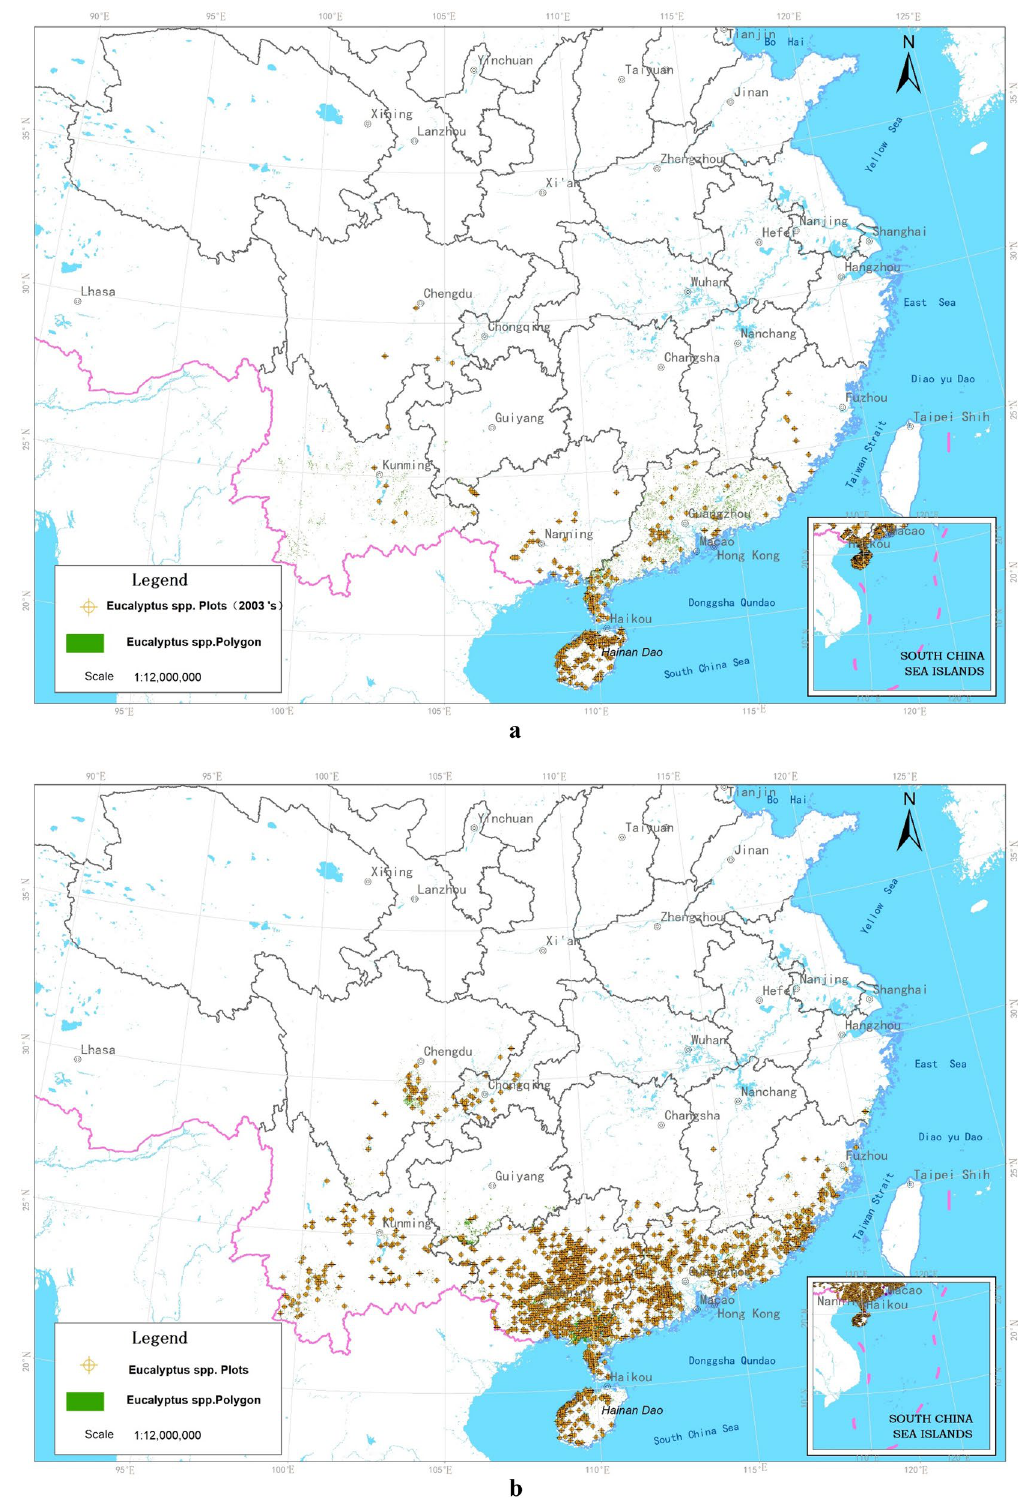
Figure 1. Distribution of eucalyptus in the south of China [( a ) 2003; ( b ) 2016]. This figure was created by spatially overlaying spatial sample plots data from National Forest Inventory (NFI) and patch vectors data from China Forest-Land Database Map (CFLDM), ( a ) shows that the point data are from 6th NFIs eucalyptus sample plots and the polygon vector data are from the 2003 CFLDM; ( b ) shows that the point data are from 9th NFIs eucalyptus sample plots and the polygon vector data are from the 2016 CFLDM. The extents of eucalyptus plantations is mainly concerned with 11 provinces (e.g. Zhejiang, Fujian, Guangdong, Guangxi) in Southern